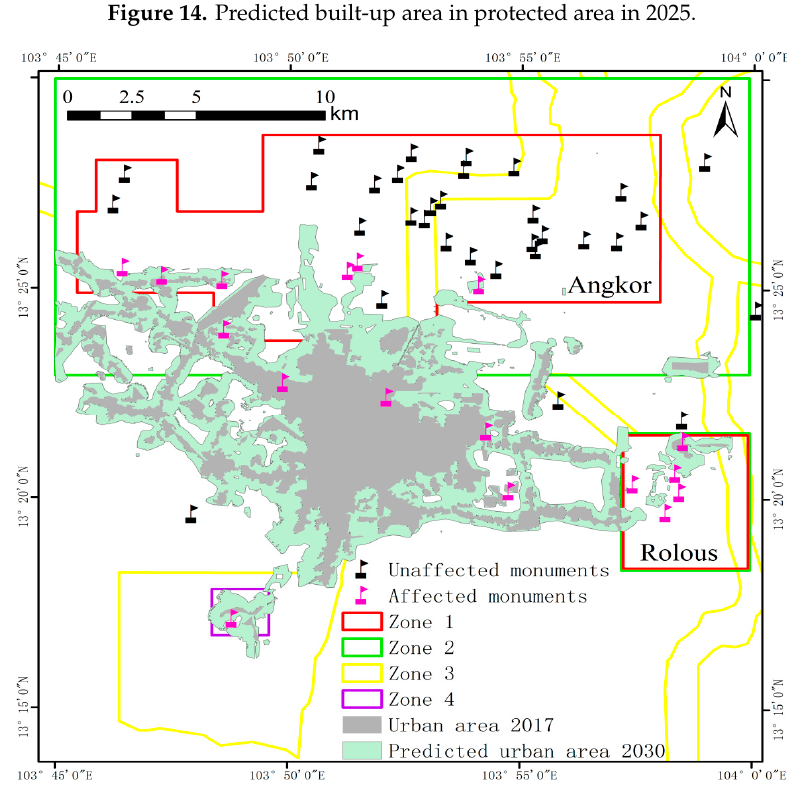
Figure 15. Predicted built-up area in protected area in 2030.